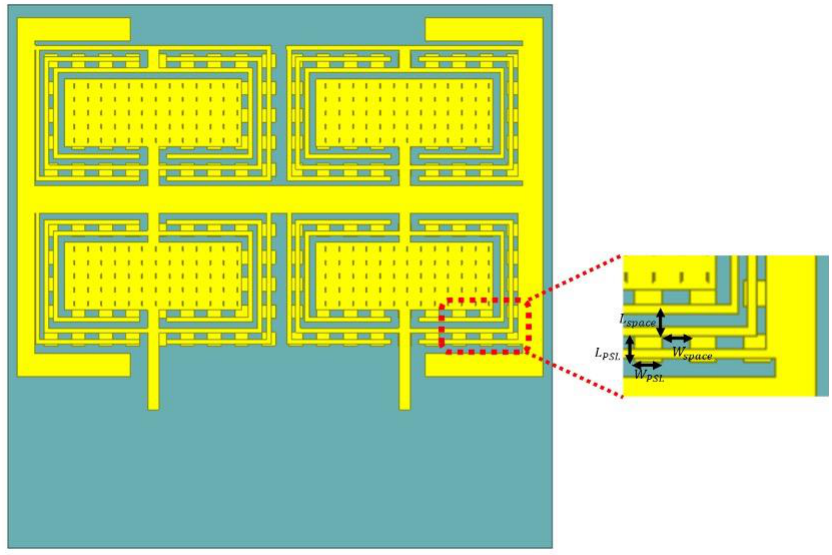
Figure 13. Antenna body plus symmetrical square metal ring and PSL. (The parameters are: 𝐿 𝑃𝑆𝐿 = 30 μm , 𝑊 𝑃𝑆𝐿 = 30 μm , 𝐿 𝑠𝑝𝑎𝑐𝑒 = 30 μm , and 𝑊 𝑠𝑝𝑎𝑐𝑒 = 30 μm .)